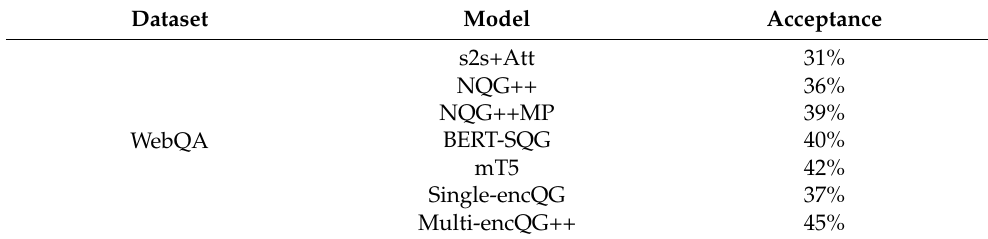
Table 6. Question accuracy results of different question generation models.